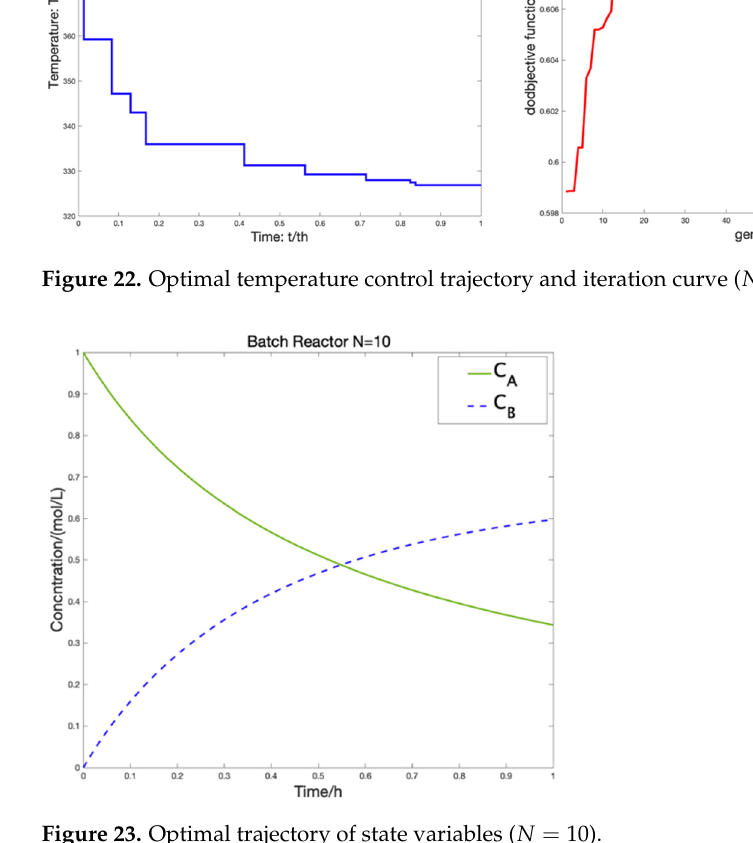
Figure 23. Optimal trajectory of state variables ( N = 10). Table 5. Comparison of methods of batch reactor ( 10 N = ).